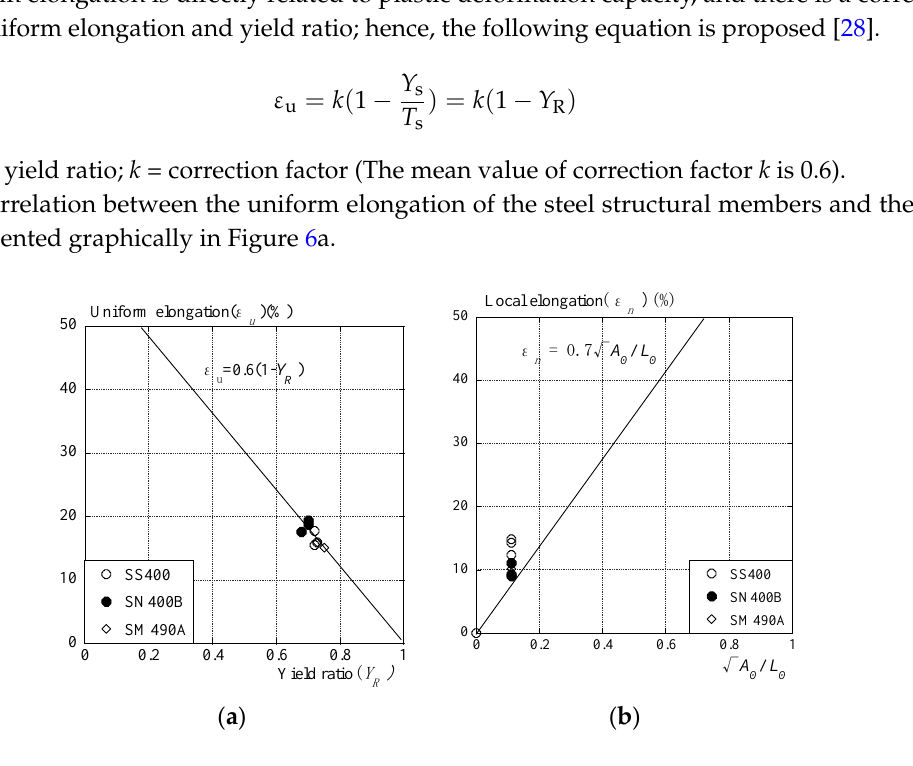
Figure 6. ( a ) Uniform elongation and yield ratio and ( b ) local elongation and